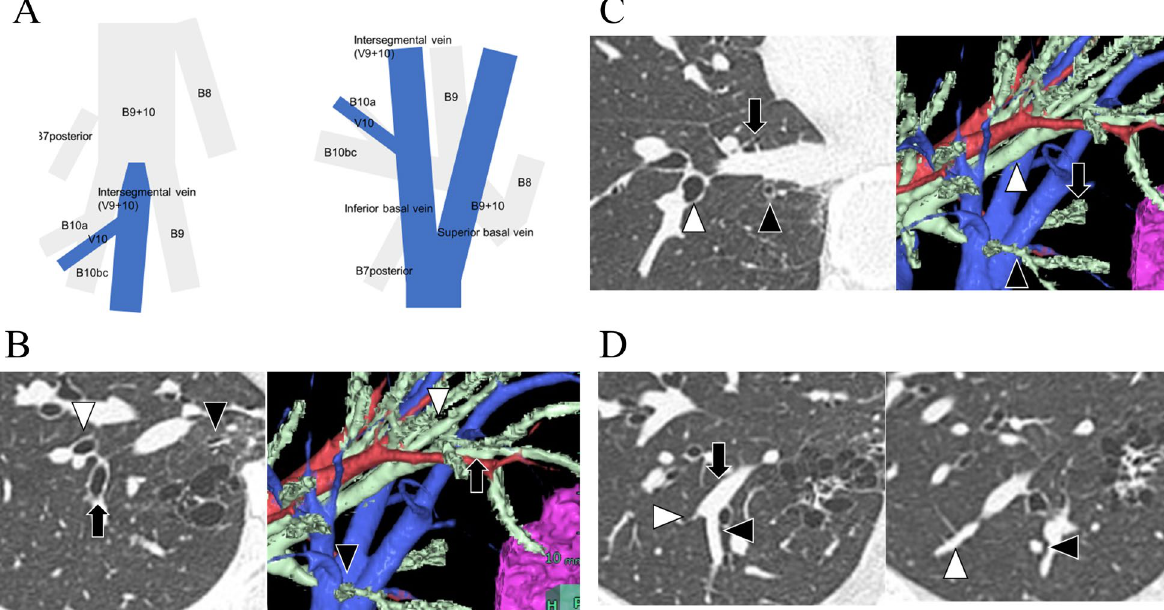
Fig. 2 Schema of the anatomy of the basilar segment and intraoperative image. A Schematic of conventional and surgeon’s views of the vein and bronchus. B B7 posterior (black arrowhead), B7 anterior (arrow), and B9 10 (white arrowhead) are shown. C The B7 posterior (black + arrowhead), B10bc (arrow), and B9 (white arrowhead) are shown. For complete resection of the lesion, it was necessary to divide the B10bc from the B7 posterior. D The V9 10 (arrow) is shown. Intersegmental vein preservation between S9 and S10 (white arrowhead) and division of the + intrasegmental vein (black arrowhead) were